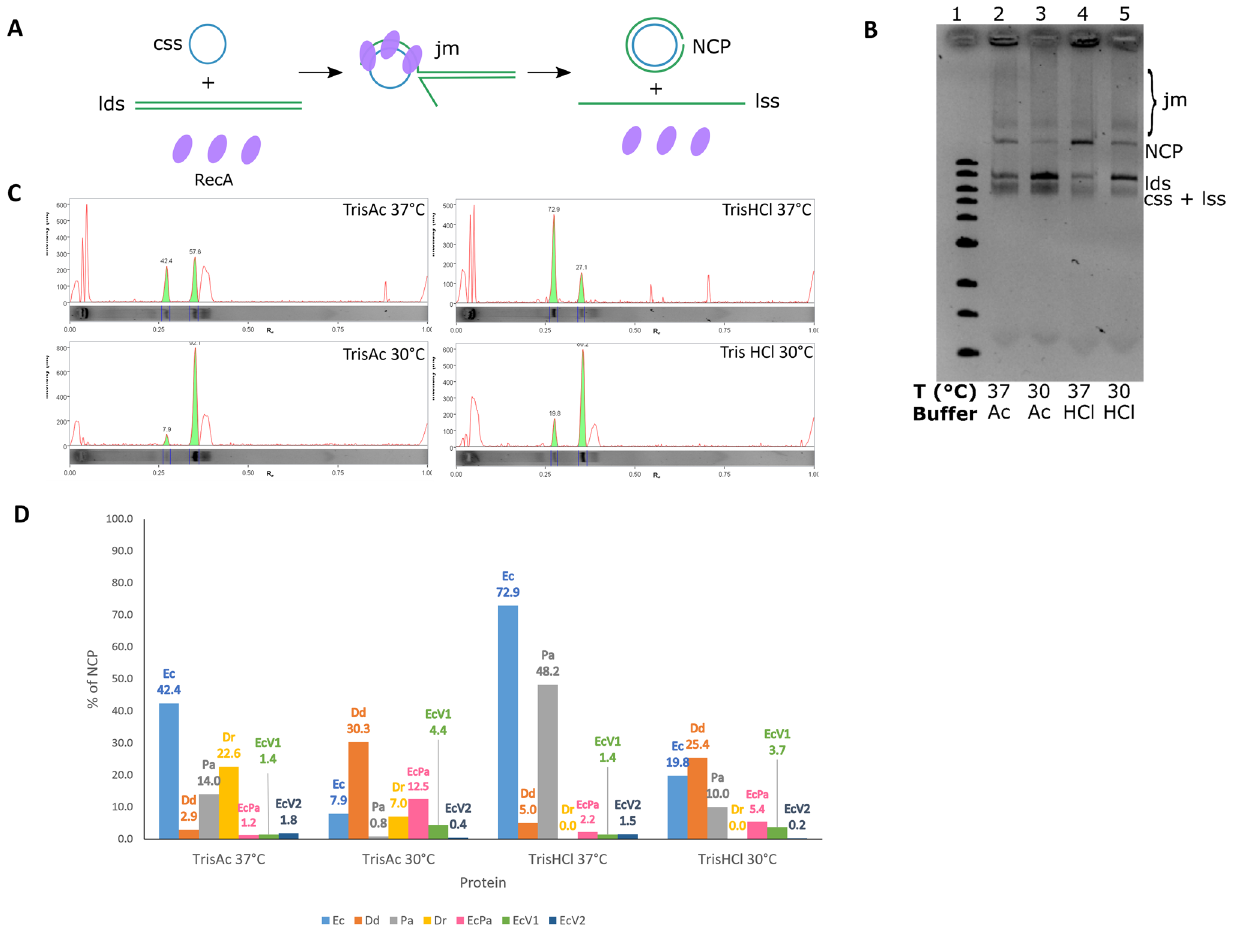
Figure 8. Efficiency of RecA variants in promoting DNA strand exchange. (A) Scheme of the three-strand exchange reaction between circular ssDNA (css, in blue) and the linear duplex (lds, in green) substrates and the expected intermediates, called joint molecules (jm), and final products, namely, nicked circular products (NCP) and linear single-stranded DNA (lss), by RecA-mediated DNA strand exchange. ( B) Example of the DNA exchange reaction obtained with EcRecA in two different buffers and temperatures, indicated above the gel. The first lane corresponds to the 1 kb ladder (full-length gel in supplementary Fig. 1). ( C) Influence of the buffer composition and temperature on the DNA strand exchange activity of RecA variants. The histogram represents the percentage of fluorescence corresponding to NCP compared to the total fluorescence (NCP plus linear dsDNA; ssDNA and joint molecules were excluded). This result correlates with the efficiency of RecA strand exchange activity. The numbers indicated are the percentages for each condition. The four conditions tested were Tris-Ac buffer pH 7.5 at 37 °C, Tris-Ac buffer pH 7.5 at 30 °C, Tris–HCl buffer pH7.6 at 37 °C and Tris–HCl buffer pH 7.6 at 30 °C for all RecA variants: EcRecA (blue), DdRecA (orange), PaRecA (grey), DrRecA (yellow), EcPa variant (pink), EcRecAV1 variant (green) and EcRecAV2 variant (dark